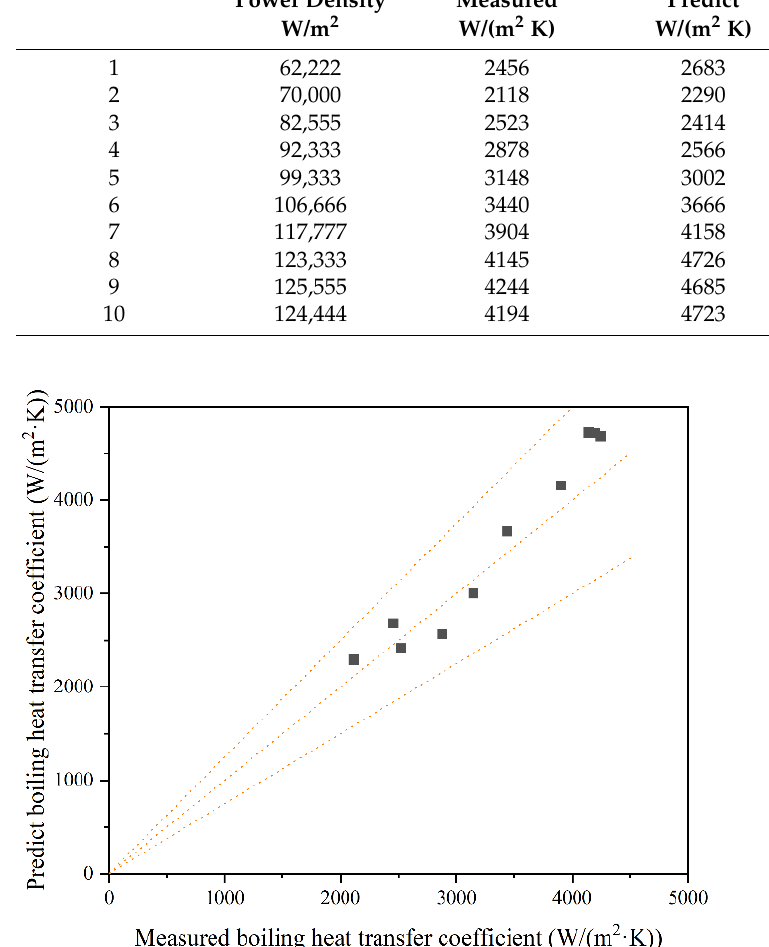
Figure 10. Error comparison between measured and predicted boiling heat transfer coefficients.